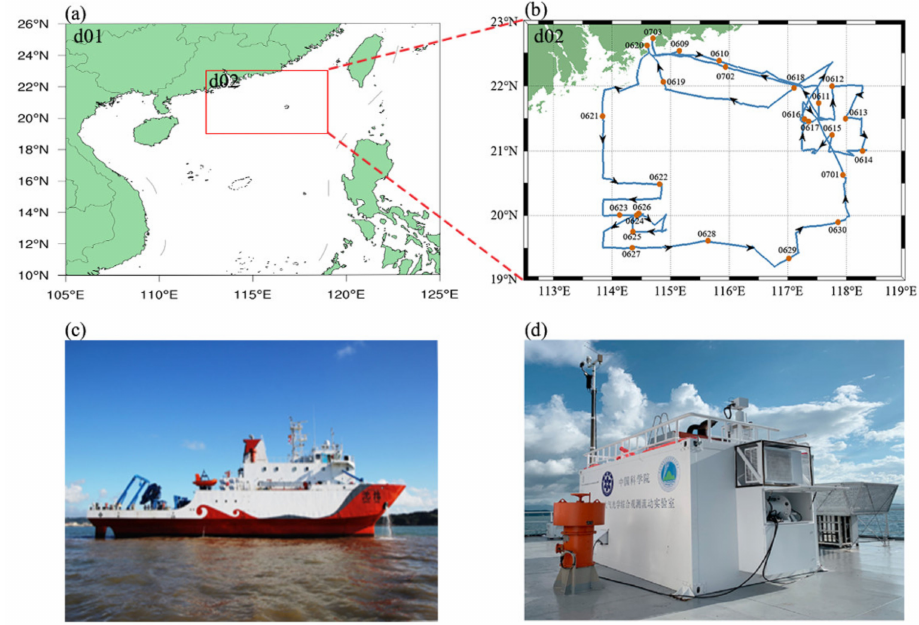
Figure 1. ( a ) the region of interest; ( b ) the cruise of Shen Kuo during June and July 2019; ( c ) the Shen Kuo research vessel; ( d ) the atmospheric optical comprehensive observation shelter on board. During this experiment, basic meteorological parameters (e.g., temperature, wind, pressure, relative humidity) on the ocean surface were observed by two automatic weather stations on both sides of the ship. Meanwhile, the vertical meteorological sounding data were obtained using a GPS sounding system (MW41) in conjunction with the RS41-SG radiosonde. Balloons were regularly released four times each day, at 00:00, 06:00, 12:00, and 18:00 (BJT),